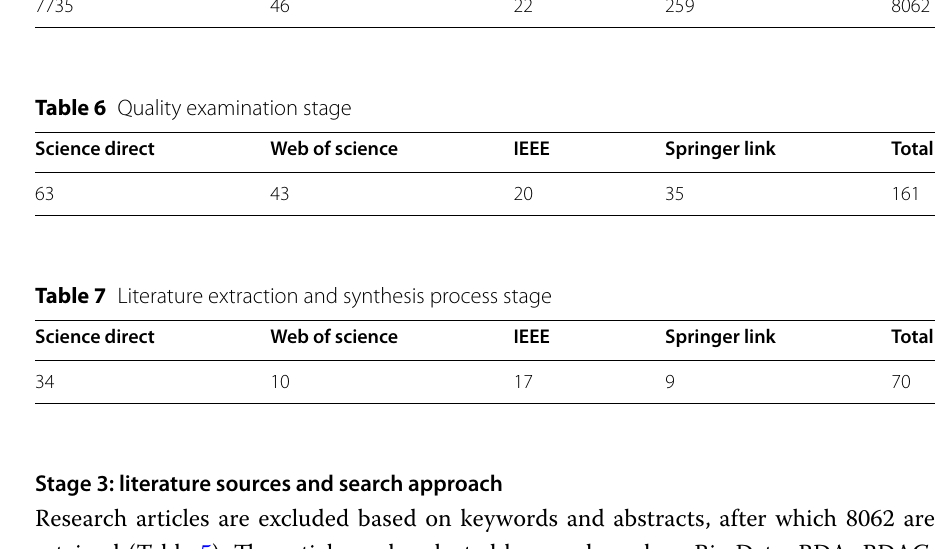
Table 5 Literature sources and search approach stage Science direct